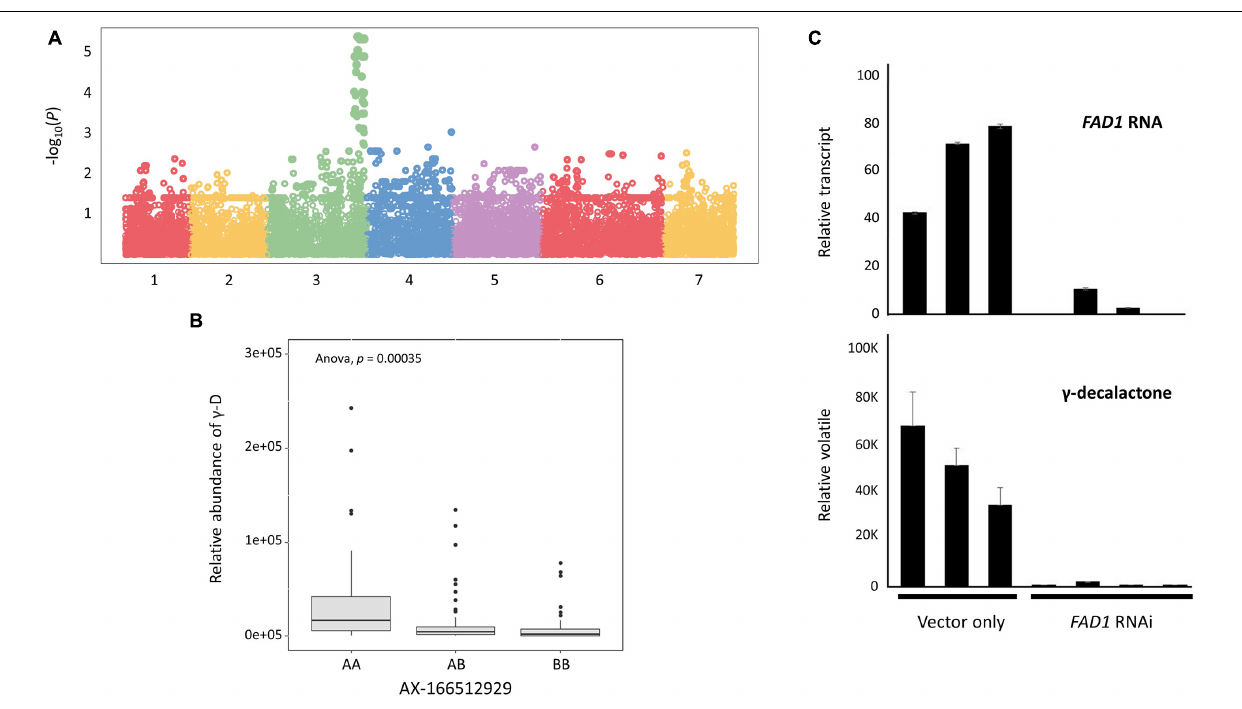
FIGURE 2 | FaFAD1 is a major locus that regulates for the production of γ -decalactone in the octoploid strawberry. (A) Manhattan plot of genome-wide association study for γ -decalactone. (B) Comparison of γ -decalactone content between different genotypes of a single marker (AX-166512929). (C) RNAi transient assay for FaFAD1 in strawberry fruit. Bars represent mean, and error bars represent standard deviation for the three biological